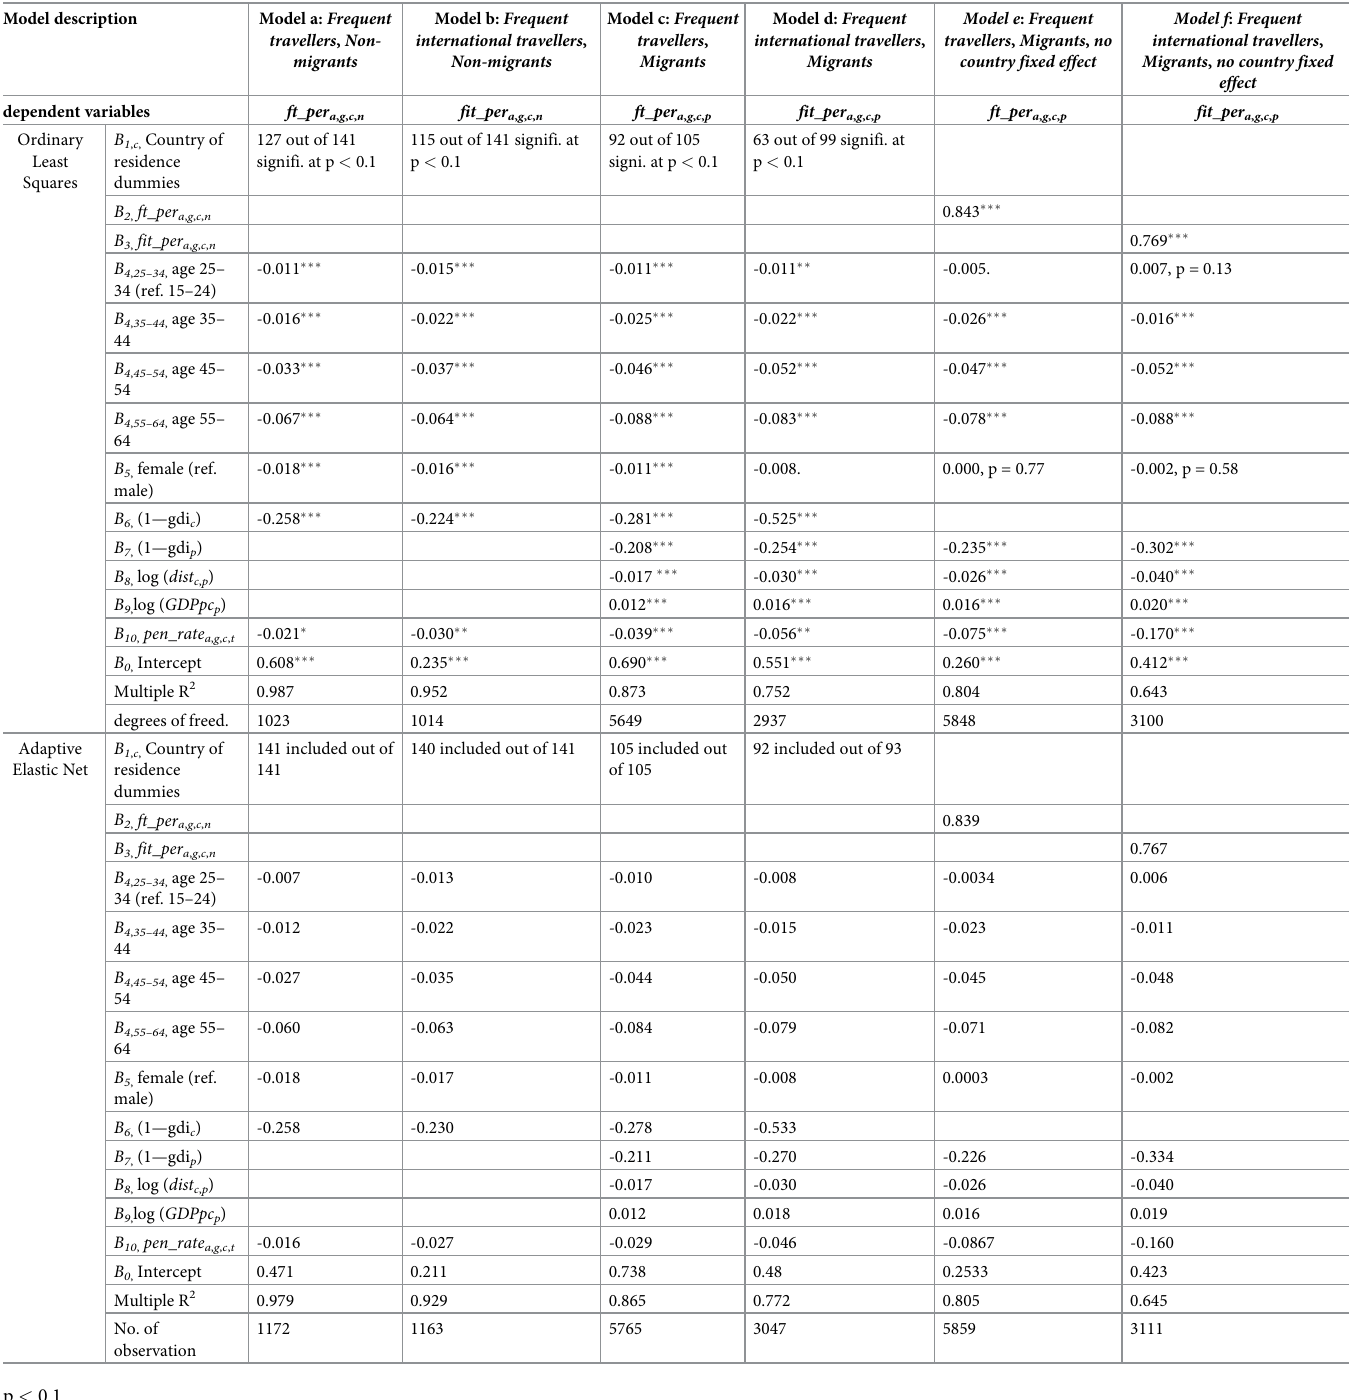
Table 1. Regression models using the OLS method and the AdaENet method. Model